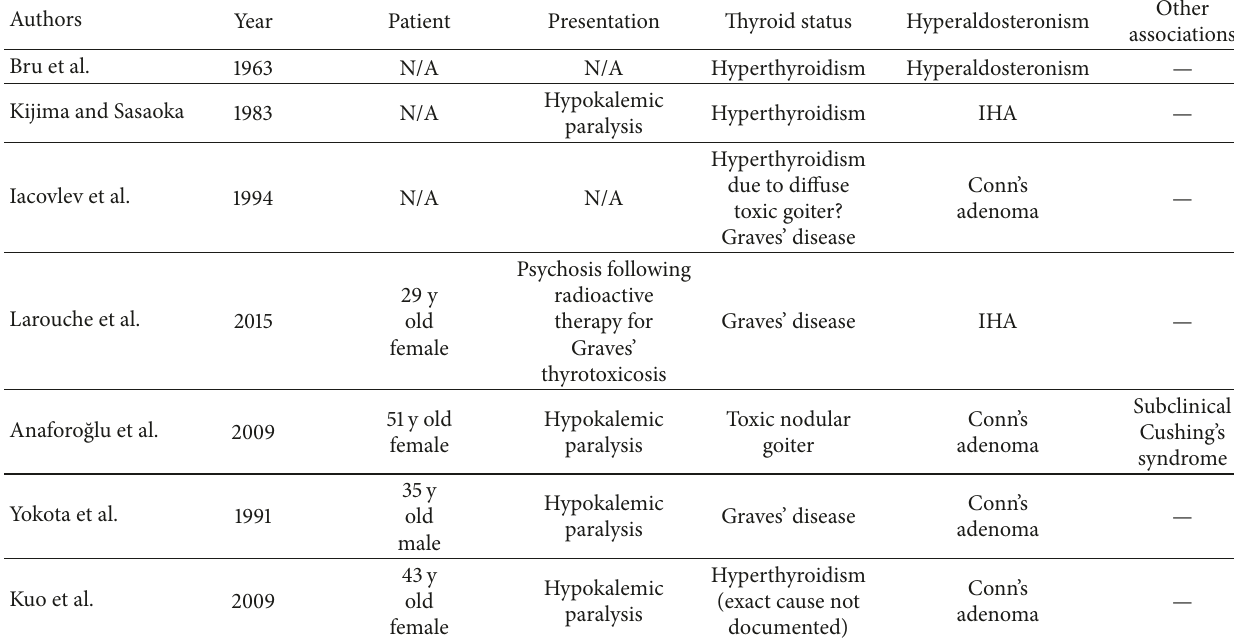
Table 1: Reported cases on hyperthyroidism and